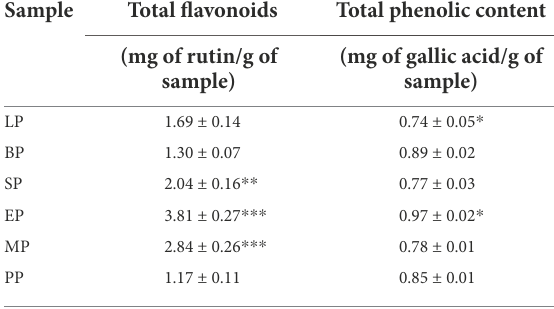
TABLE 1 Effect of different fermentation group on the flavonoid and phenolic content.